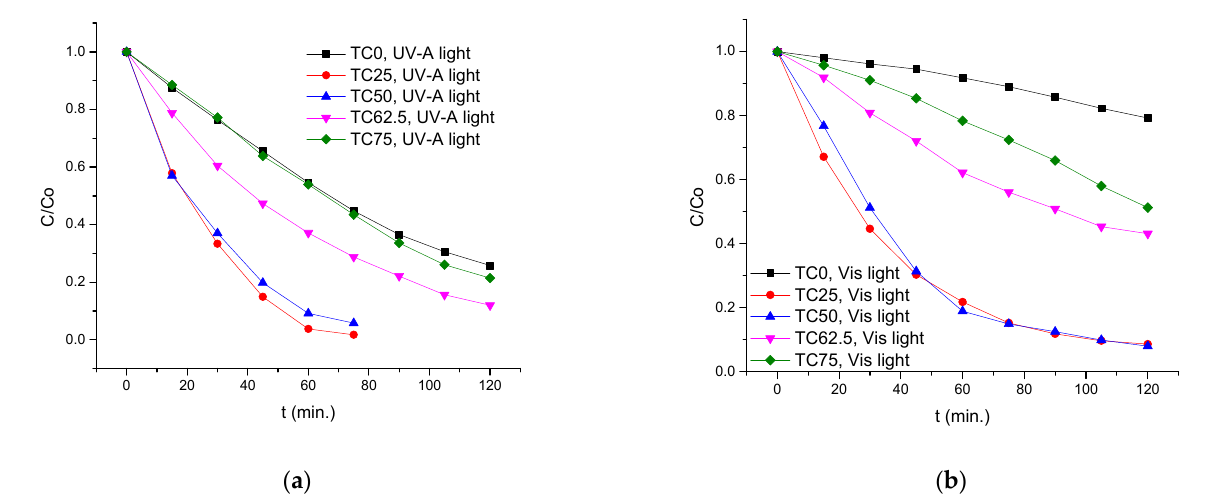
Figure 8. MO degradation rates in the presence of TC0–75 photocatalysts under ( a ) UV-A and ( b ) simulated solar irradiation.